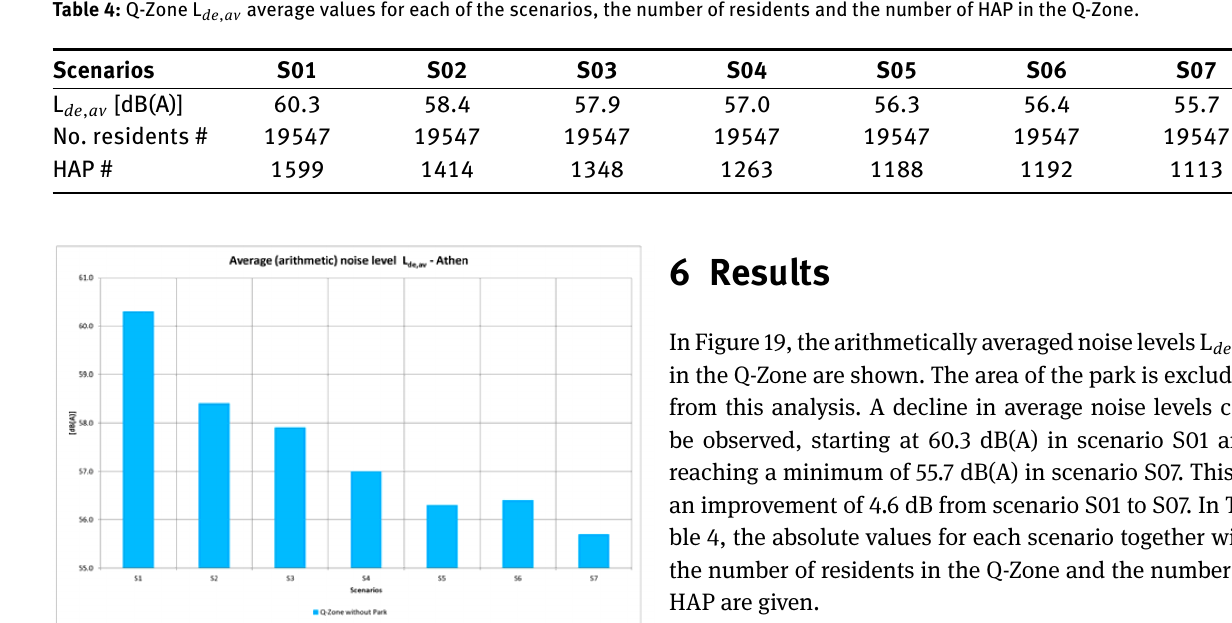
de , av in the Athens Q-